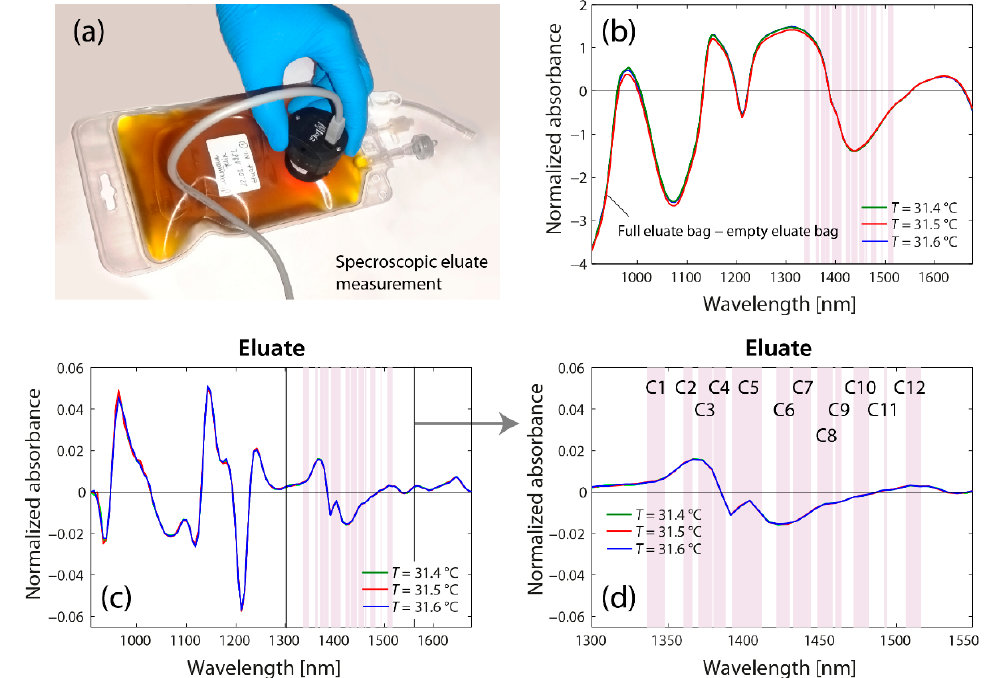
Figure 2. ( a ) Measurement of the eluate. ( b ) Raw spectra. ( c ) Difference spectra. ( d ) Zoomed-in part of ( c ) highlighting the region with the 12 WAMACS.